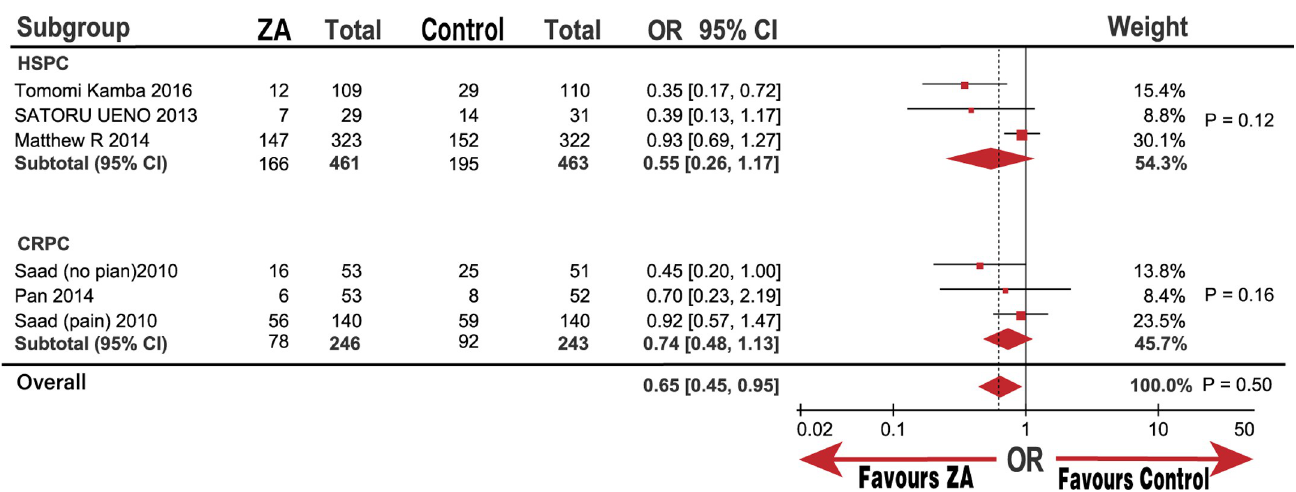
PLOS ONE | https://doi.org/10.1371/journal.pone.0275176 September 22, 2022 10 /